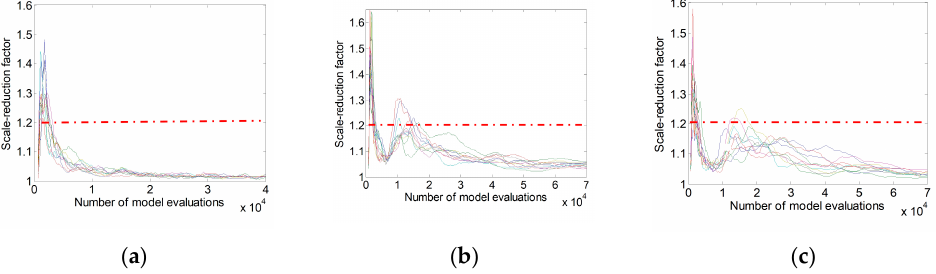
Figure 3. Evolution of the scale reduction factor for the eight estimation parameters: ( a ) Case 1: 0% noise + Full Outputs; ( b ) Case 2: 10% noise + Full Outputs; ( c ) Case 3: 10% noise + Partial Outputs.